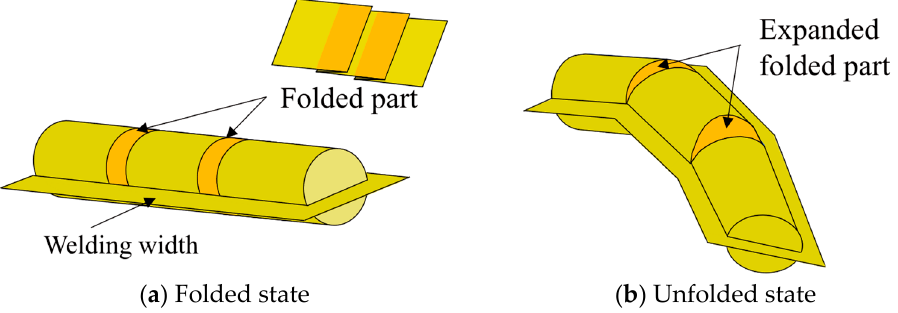
Figure 1. Schematic view of pneumatic bellows actuator of PI films: ( a ) folded actuator; ( b ) unfolded actuator by applying gas pressure.